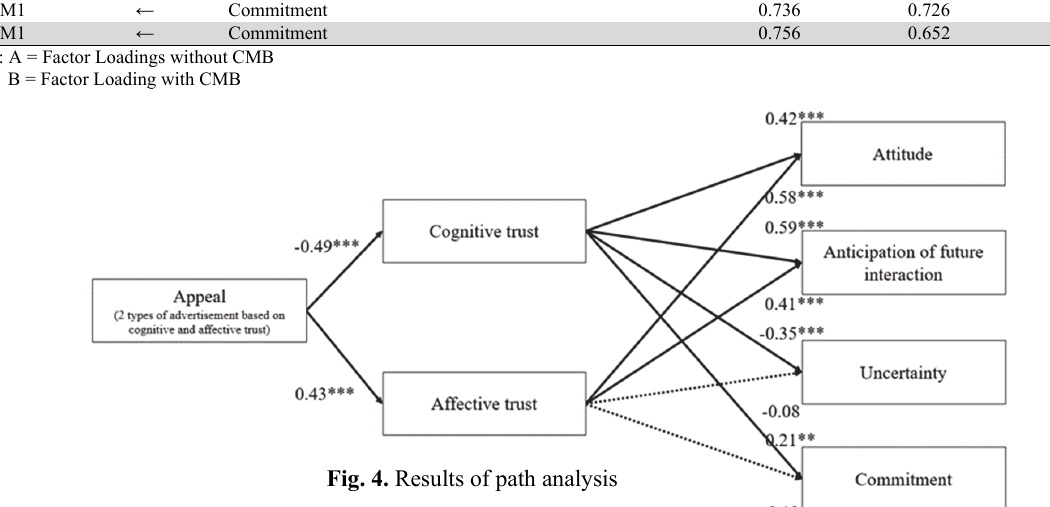
Fig. 4. Results of path